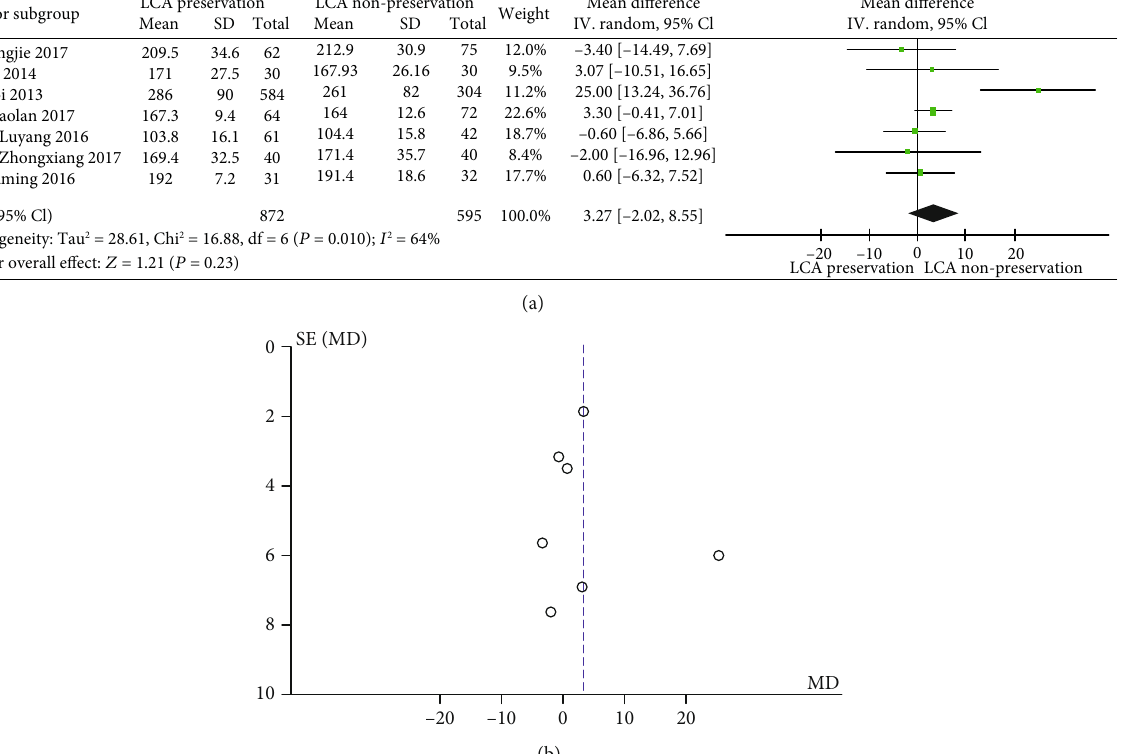
Heterogeneity: Tau 2 = 28.61, Chi 2 = 16.88, df = 6 ( P = 0.010); I 2 = 64%